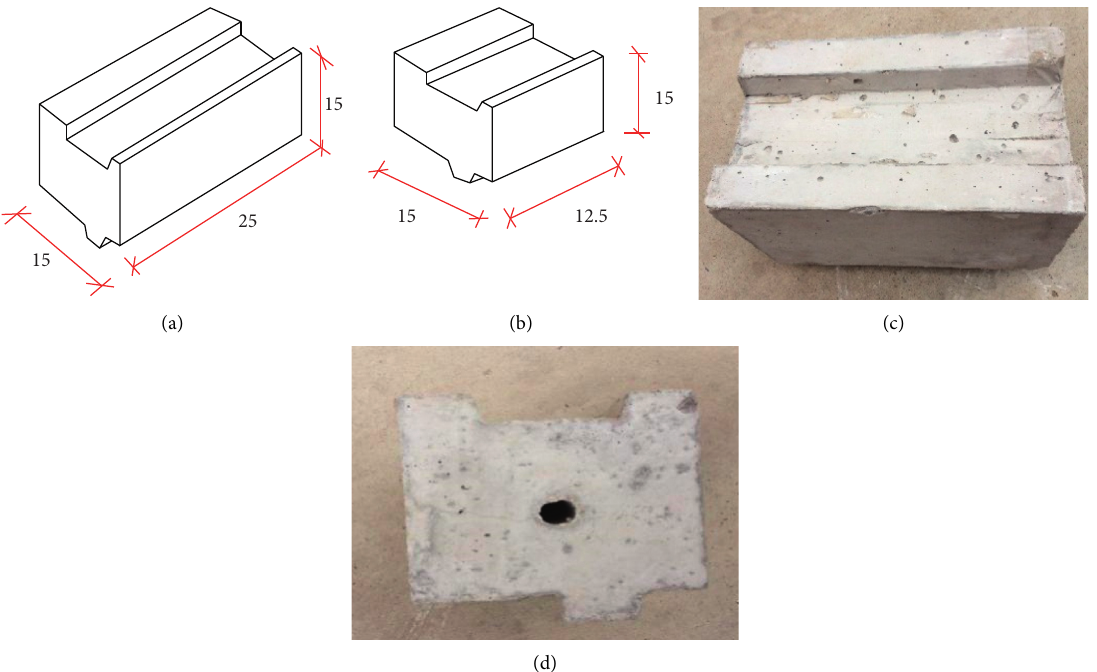
Figure 5: Modular block: (a) block sample 1, (b) block sample 2, (c) block front, and (d) block side.